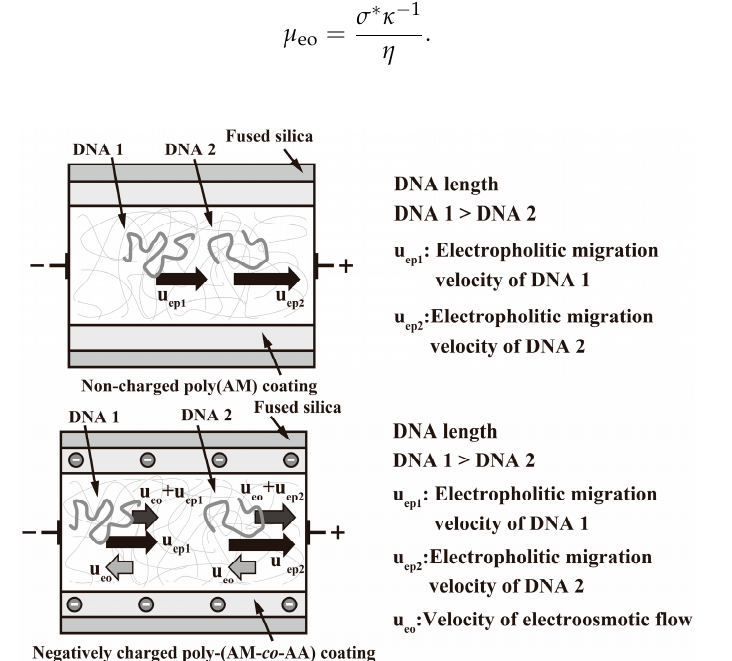
Figure 4. Method used to enhance CGE peak separation of DNA samples.